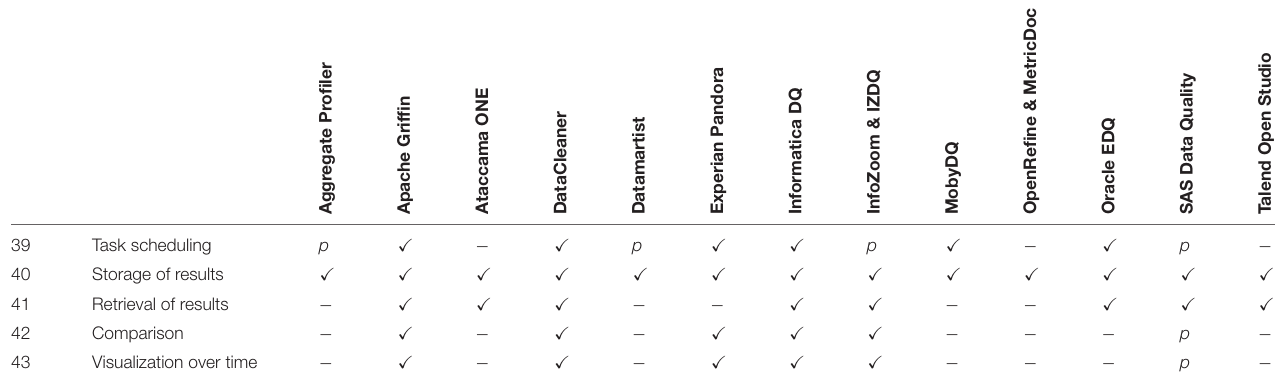
TABLE 10 | Data quality monitoring